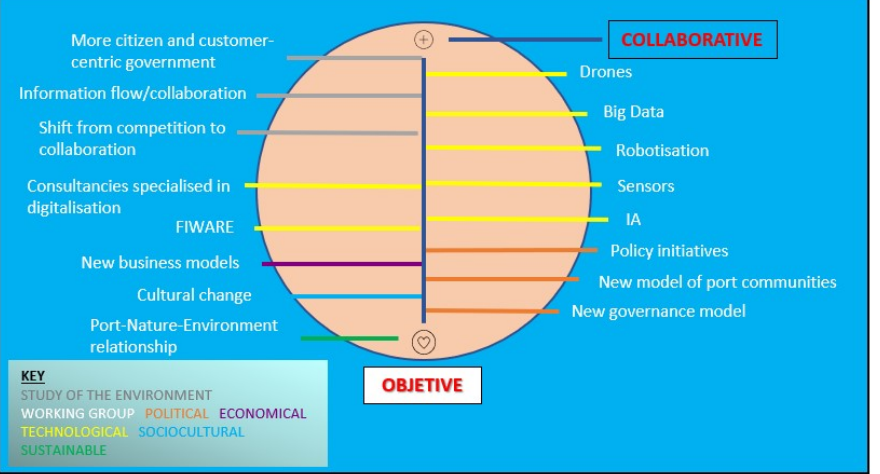
Figure 17. Elements of collaborative ports. Source: own elaboration. In order to meet the growing demands of its customers, it is necessary to involve far fewer blocks and indicators. There are only indicators from the following blocks: study of the environment, working group and technological. It is important to highlight the new employee profiles and job opportunities indicator, which is very important for the future of digital governance.